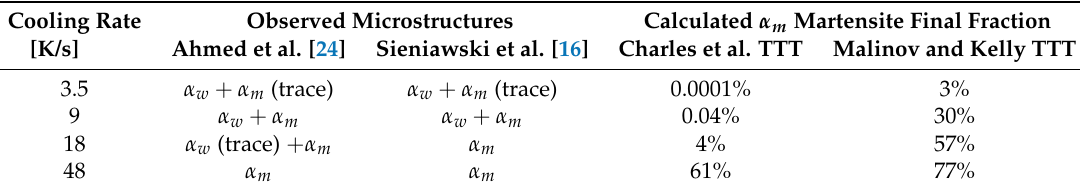
Table 2. Martensite content at the end of continuous coolings. Comparison between observed microstructures in literature and results obtained with different TTT data